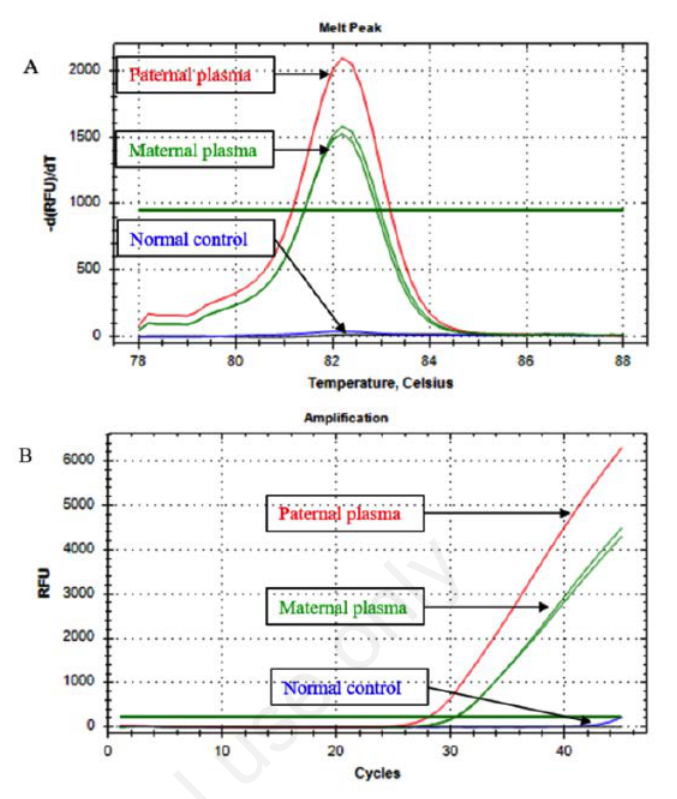
Figure 1. Image of the PIBTM melt peak and cycle threshold of the CD41/42-CTTT using specific ARMS RT- PCR primers. The paternal and the paternally inherited CD41/42-CTTT melt appearance were similar and were at the same temperature at 82.00±0.25°C (A). The paternal cycle threshold for the beta thalassemia mutations in paternal plasma and the cycle threshold of the paternally inherited cell-free fetal DNA in maternal plasma